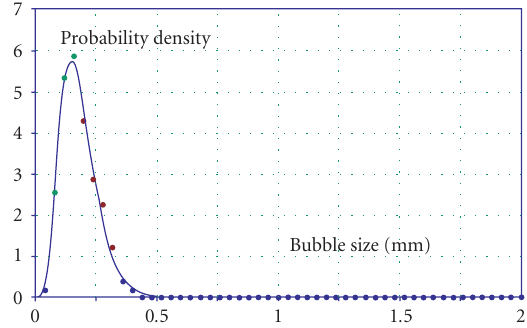
Figure 3.17. Bubble size distribution function (immediately after foaming up, t ≈ 0s); the probability density is shown as a function of the bubble sizes.